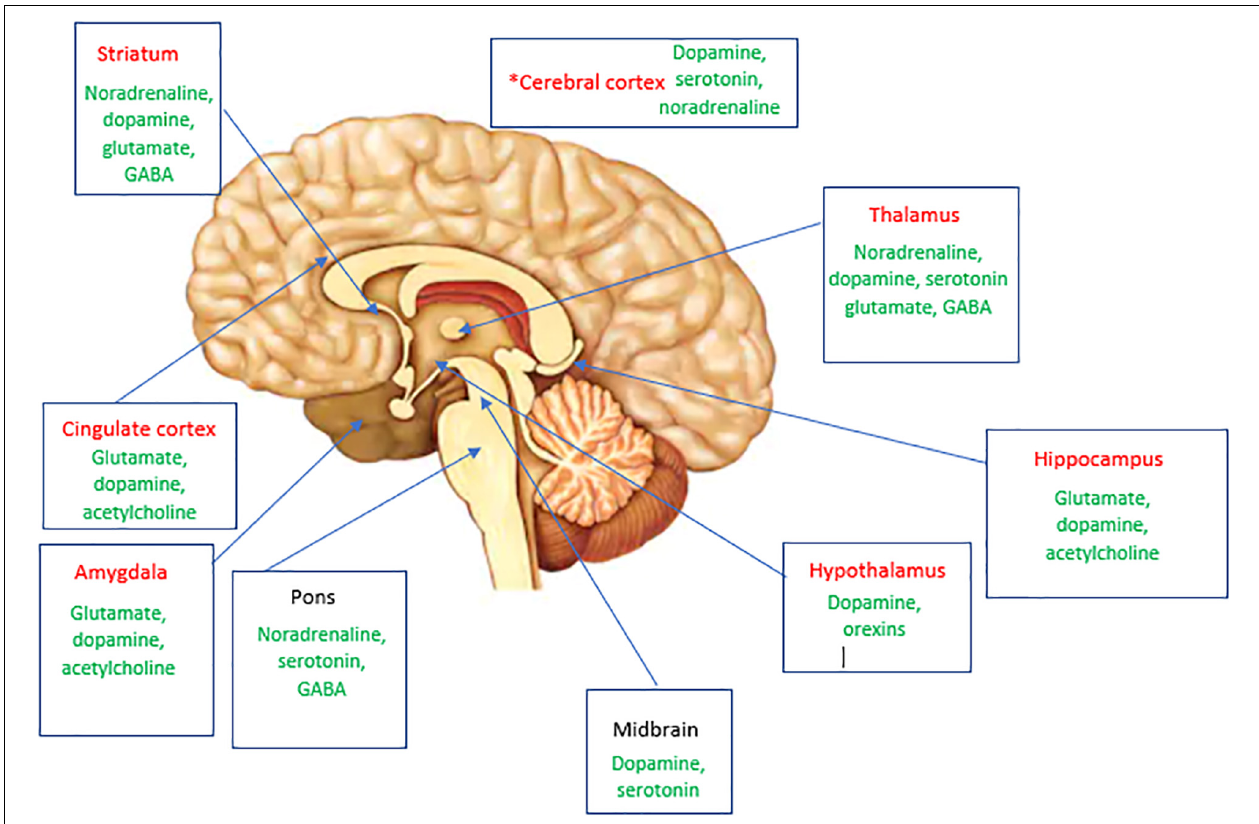
FIGURE 1 | A summary of brain areas likely to be involved in mediating both pain and mood and arousal complaints in migraine via structural and functional connections. Thalamocortical pathways that modulate sensory and cognitive processing are also involved. Neurotransmitters implicated in these areas in migraine are shown in green. *Specific cortical areas implicated include dorsolateral prefrontal cortex, orbitofrontal cortex, anterior cingulate cortex, and the primary somatosensory cortex. Areas highlighted in red are likely to also have a role with their associated neurotransmitters in fatigue and